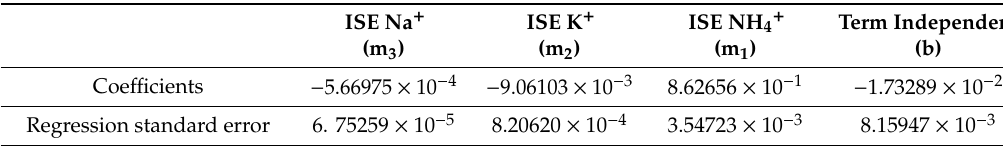
Table 4. Results of the linear regression.